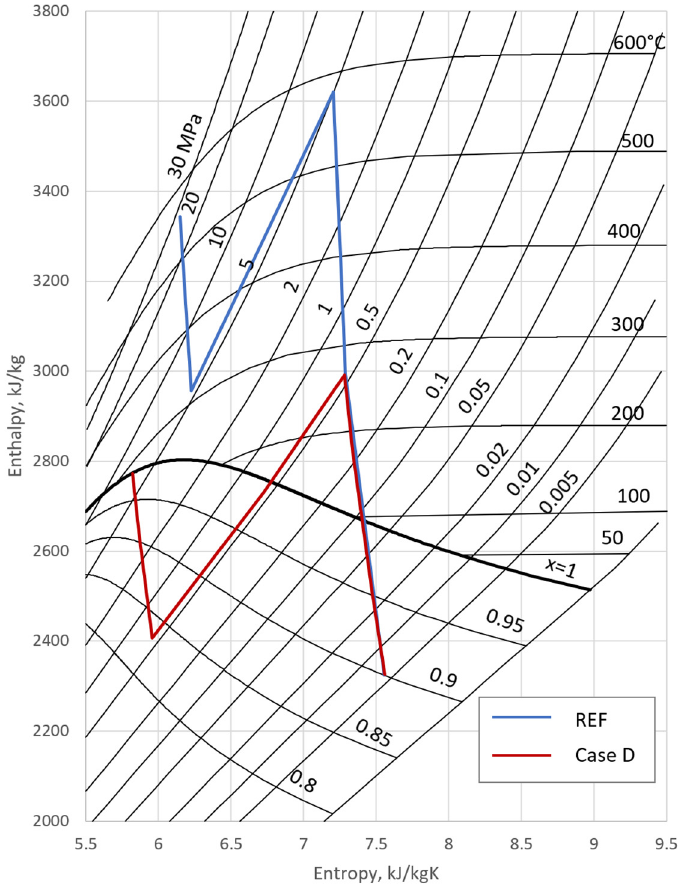
Figure 9. Steam expansion line in the turbine of the 460 MW power unit (REF) and post-modernization state (Case D).